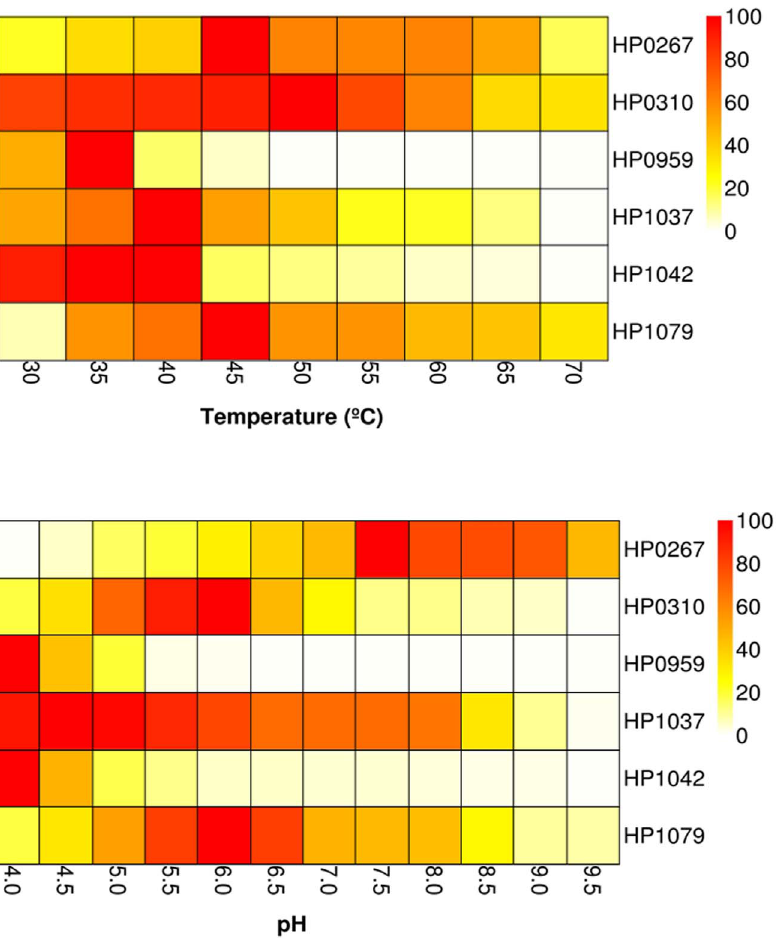
Figure 1. Optimal temperature (upper) and pH (lower) for hypothetical proteins from H.pylori . The heat map colors represent the relative percentages of activity (in terms of k cat ) as compared to the maximum (100%) within each enzyme. k cat values were determined using nonlinear regression to fit the values for initial velocity and substrate concentration to the Michaelis-Menten equation as described in Materials and Methods. The pH dependence of a reaction was tested in the range of pH 4.0–9.5 at 30 u C, and the temperature dependence in the range of 30–70 u C at the optimal pH (4.0 for HP0142 and HP0959; 6.0 for HP0179 and HP0310; 7.5 for HP0267; and 4.5 for HP1037). The buffers used were: citrate (pH 4.0–5.0), acetate (pH 5.0–6.0), MES (pH 6.0–7.0), HEPES (pH 7.0–8.0), Tris-HCl (pH 8.0–9.0) and glycine (pH 9.0–9.5), all at 100 mM. Reaction conditions: [E] o = 0–12 nM, [substrate: HP0310 ( p NPacetate and acetylated xylan), HP0267 (adenosine), HP1037 (N-succinyl-Ala-Ala-Ala-Pro-Phe- p -nitroanilide), HP1079 (ATP), HP0959 (GTP), HP1042 (bis- p NPP)] ranging from 0 to 20 mM. Three independent experiments were performed for each parameter and graphs were plotted using mean values.